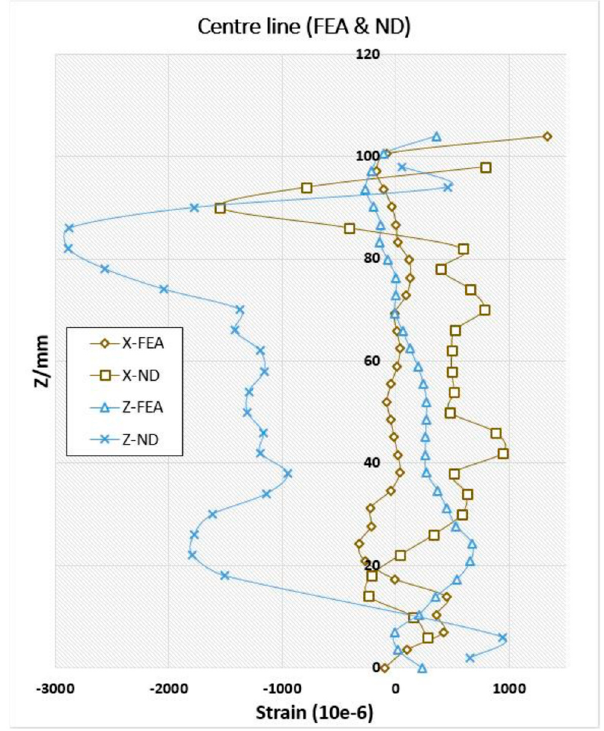
Figure 13. Comparison of the predicted strains from the FEA model with neutron diffraction (ND) by way of model validation in the X and Z directions.